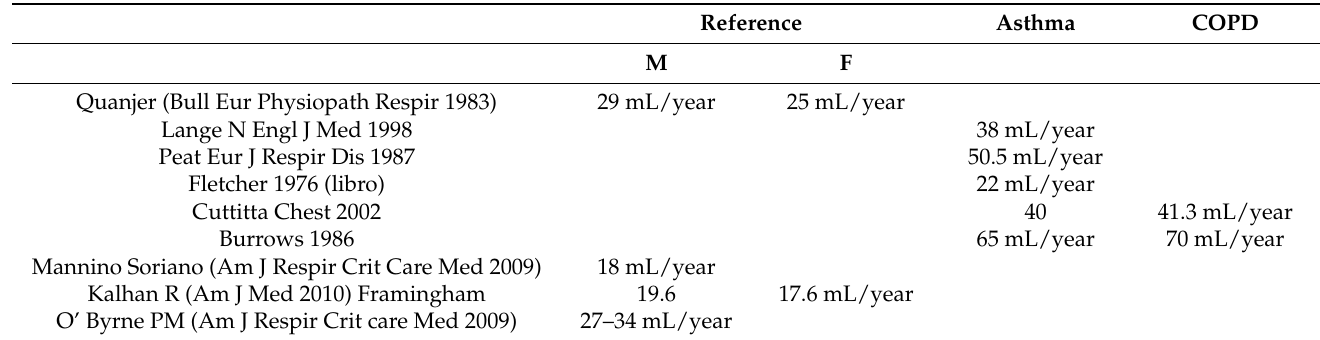
Table 2. Overall FEV 1 rate of decline compared with other studies. FEV 1 decline values were separately calculated for a male and a